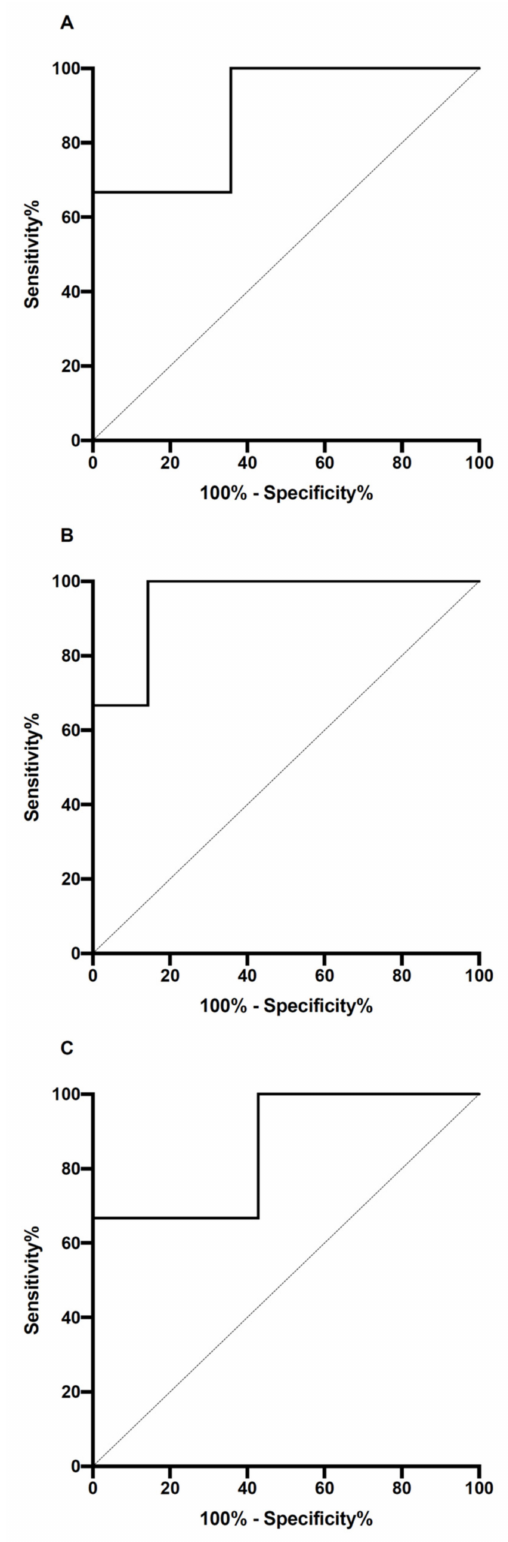
Figure 2. ROC curve analysis of aldosterone for obstructive CAKUT needing surgery. Panel ( A ), global population. Panel ( B ), patients with LUTO. Panel ( C ), patients with UUTO. All patients with early-in-life serum aldosterone levels ≥ 100 ng/dL needed surgery during the follow-up. In all cases, the levels of aldosterone normalised within 6 months of